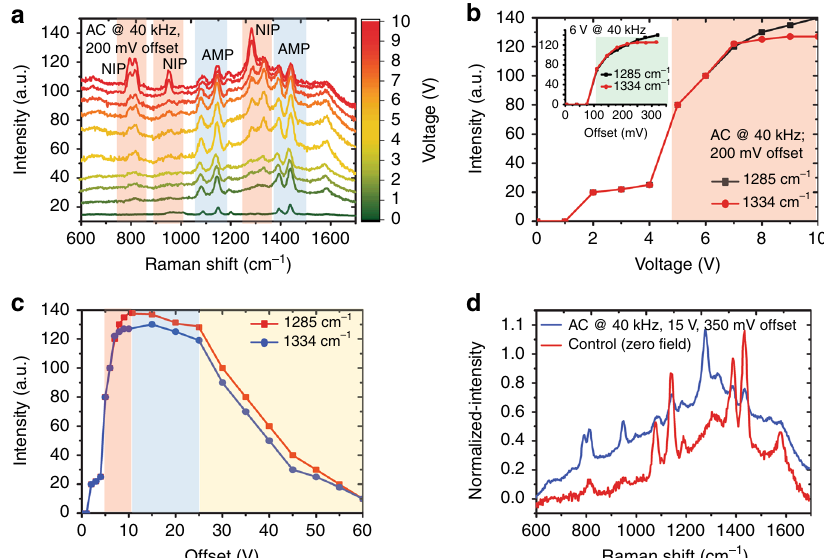
Fig. 6 SERS study of 2-AMP on the template in an applied electric fi eld. a SERS measurements of 2-AMP on the FF-PNT/Ag NP template at different electric fi elds strengths, applying voltages from 0 – 10 V at 40 kHz AC with offset bias of 200 mV. b , c Corresponding Raman band intensity of bands associated with 2-NIP as a function of voltage. b Critical threshold voltage ~4 V required for the formation of 2-NIP. Inset shows the SERS signal strength as a function of offset bias. c The window of 10 – 20 V is optimal for 2-NIP product yield via photocatalysis, with SERS intensity reducing above ~ 25 V. d Normalized SERS spectra, comparing a fully relaxed control sample at zero fi eld (red) to the spectrum recorded with applied fi eld (blue). The